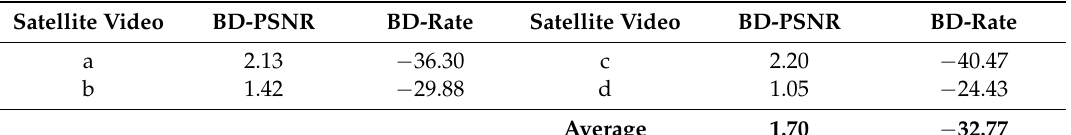
Table 4. The overall BD-PSNR (dB) and BD-Rate (%) of LBRL-x264 vs. x264 with satellite video data. Satellite